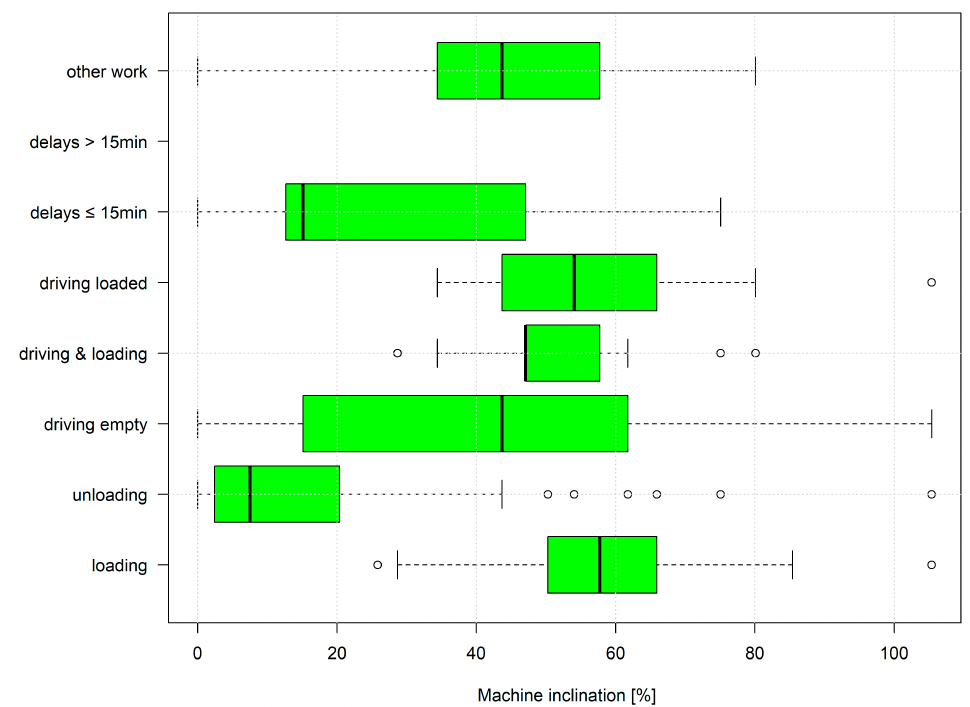
Figure 13. The recorded machine inclination for the forwarder during the study for a selected time period. Each box plot contains whiskers including data from 2.5% to 97.5%, boxes from 25% to 75%, and the black line denotes the median. Outliers are marked as points.